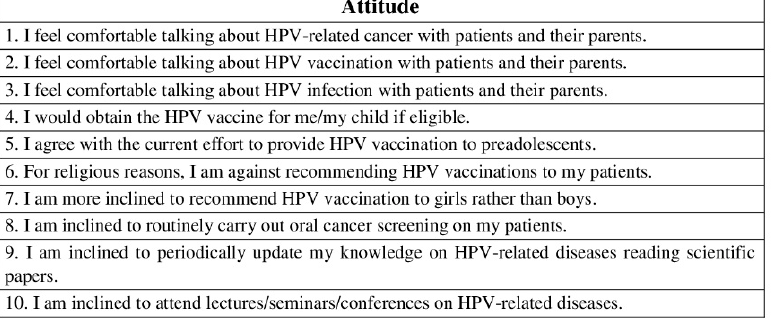
Figure 5. Questionnaire assessing pediatric dentists’ attitude on HPV-related OP-cancer, HPV infection, and HPV vaccine. Level of agreement to each statement was assessed by a five-point Likert scale: 1. strongly disagree; 2. disagree; 3. neither agree nor disagree; 4. agree; 5. strongly agree.